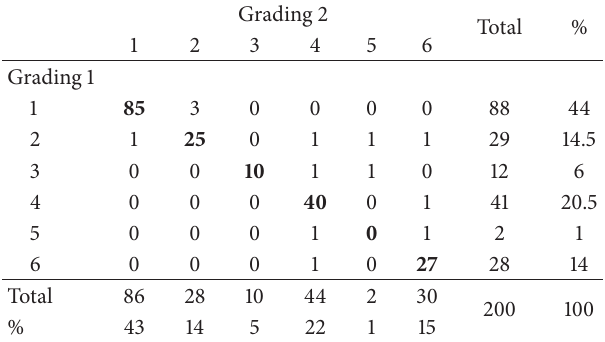
Table 3: Cross-classifications of both gradings given by 4 experts are calculated for 50 swallows: the pattern of agreement (diagonal) and the total frequency of assigned scores for gradings 1 and 2 are shown.